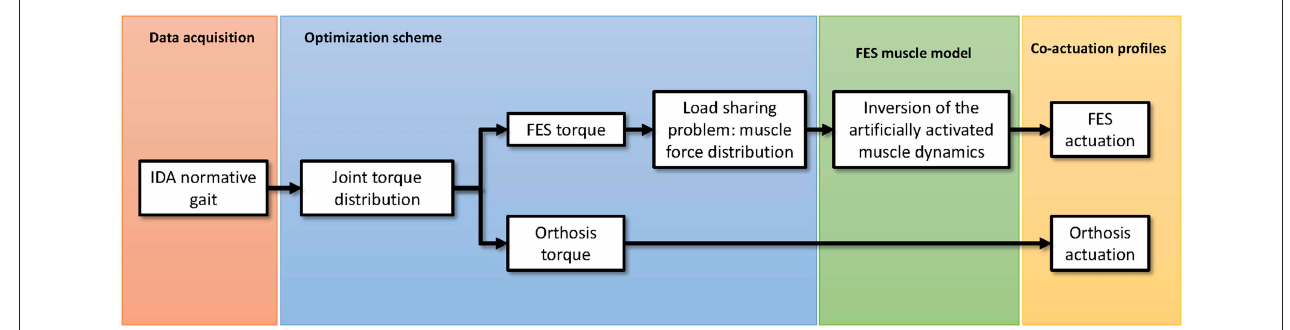
FIGURE 1 | Schematic representation of the proposed algorithm to estimate the co-actuation profiles in hybrid orthoses.